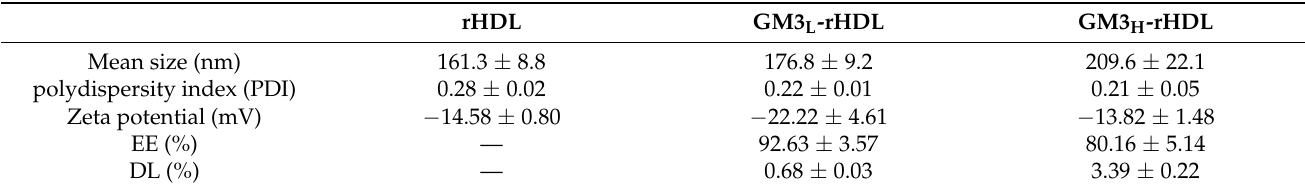
Table 1. Mean size, PDI, Zeta potential, EE, and DL (mean ± SD, n = 3).